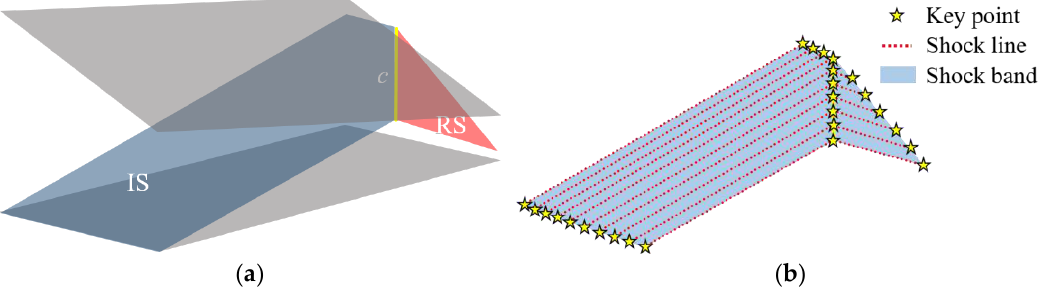
Figure 9. Shock waves detected by the method proposed in this paper: ( a ) shock surfaces and reflection lines, ( b ) the “point -line-band- surface” structure for shock topology.